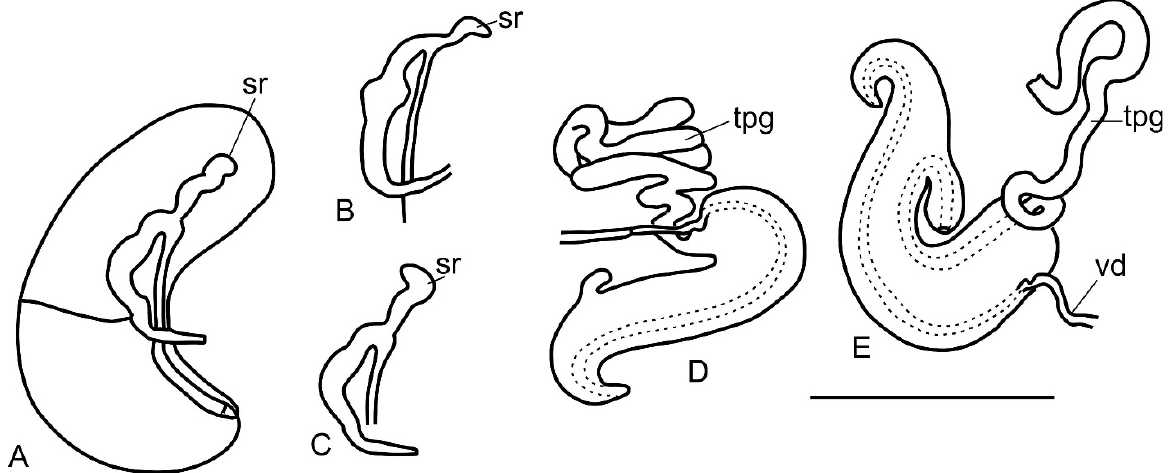
Figure 6. Drawings of reproductive organs of Kolhymamnicola . ( A ) Female gonoduct of K. kolhymen-